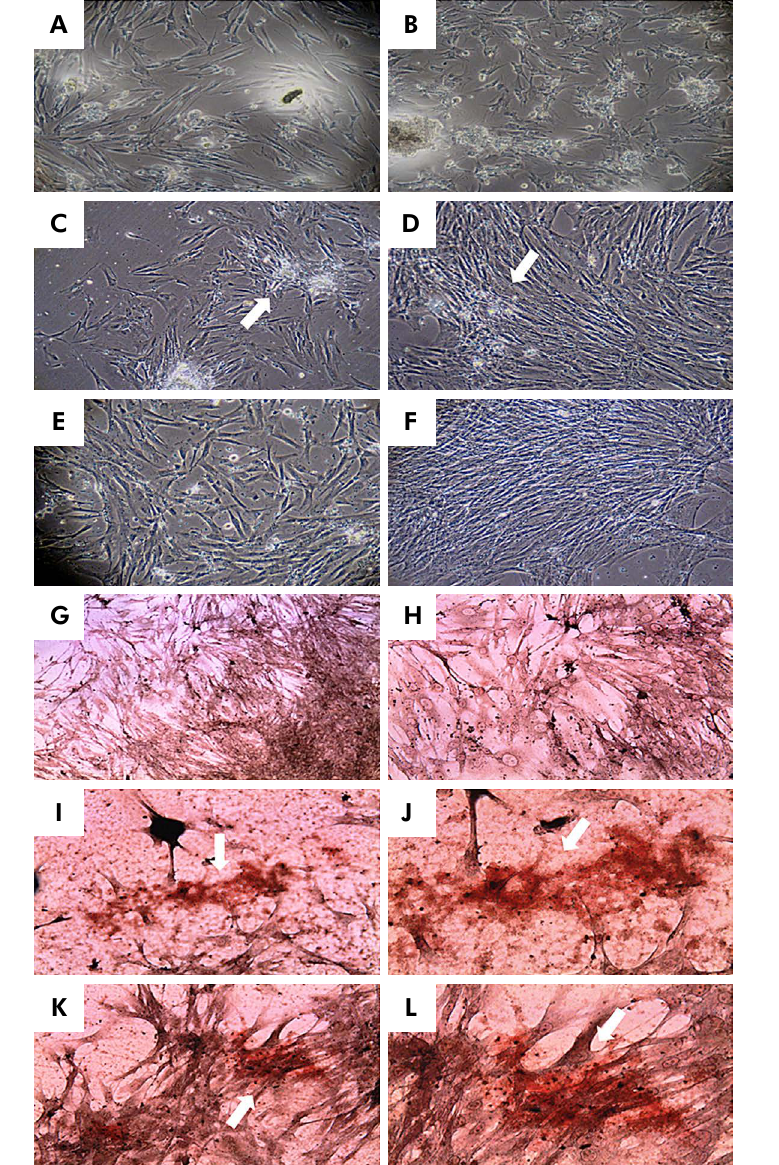
Figure 3. The cell proliferation and colony formation (arrows) during the culture period [(A, C and E): (-) group. (B, D and F): (+) group. (A and B): 7 th day; (C and D): 14 th day; E and F: 21 th day, inverted microscopy x100]. No sign of mineralization in the (-) group (P1, G: x20; H: x40). The foci of mineralization (arrows) indicating odontogenic differentiation from the third week of culture after alizarin red staining in the (+) group (P1, I and K: x20; J and L: